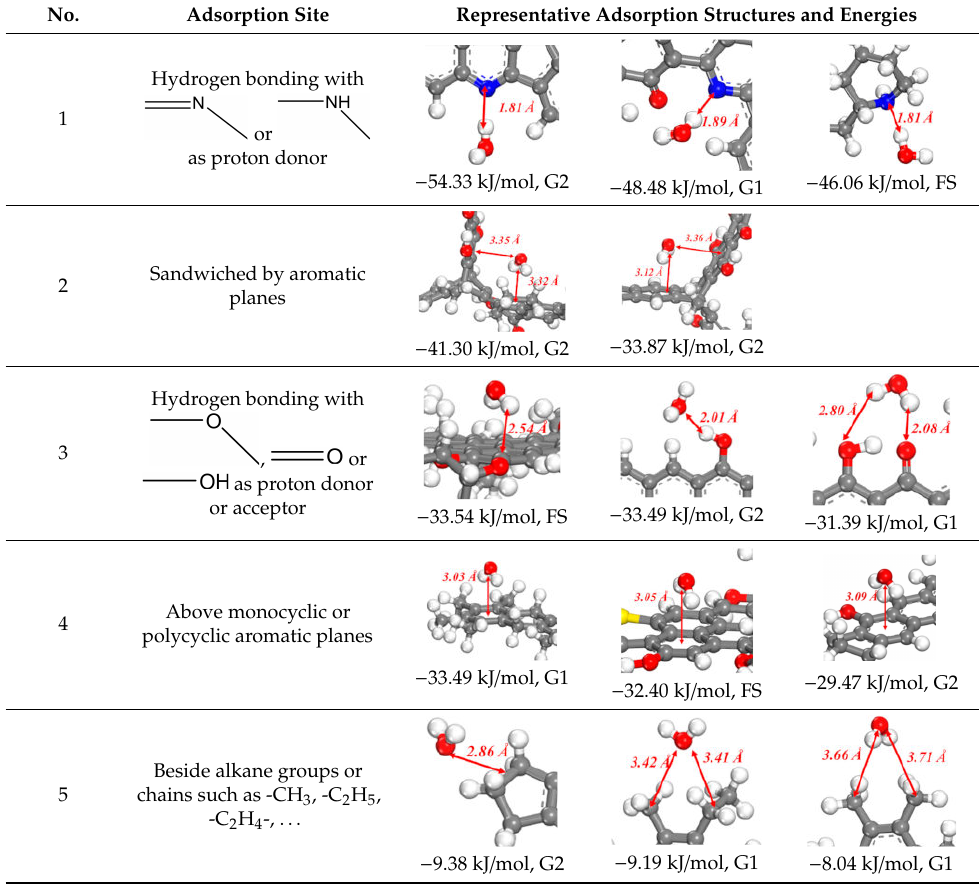
Table 3. H 2 O adsorption structures and energies on di ff erent types of adsorption sites of coal.